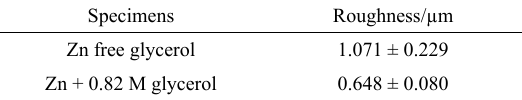
Table 6. Roughness values of Zn